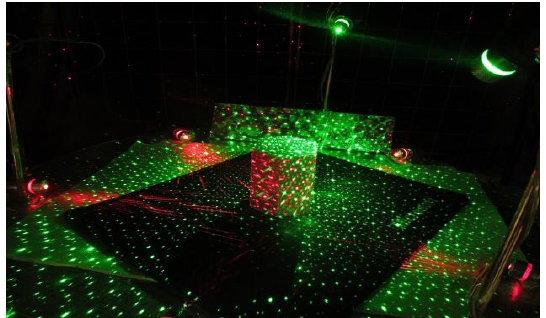
Figure3- The dot patterns projected on the object